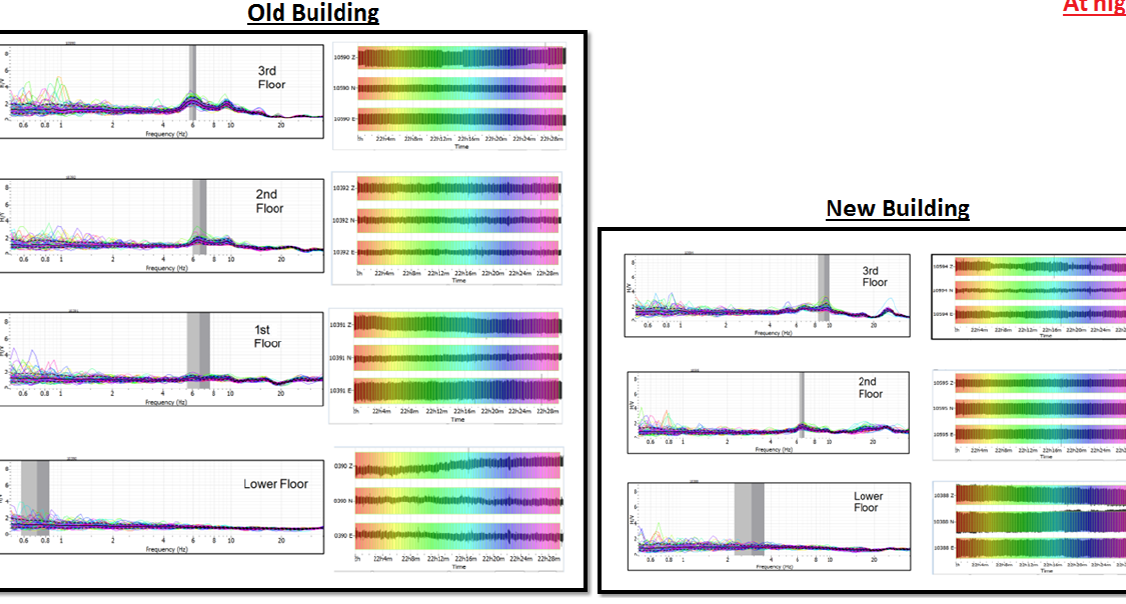
Figure 16. Programmed 30min HVSR recordings on 7 May 2013, 22:00UMT (8 May 2013, 01:00LT) on the old (left) and new (right) building of TEI. On the right is the presentation of 25s time duration windows which are extended in the whole length of the